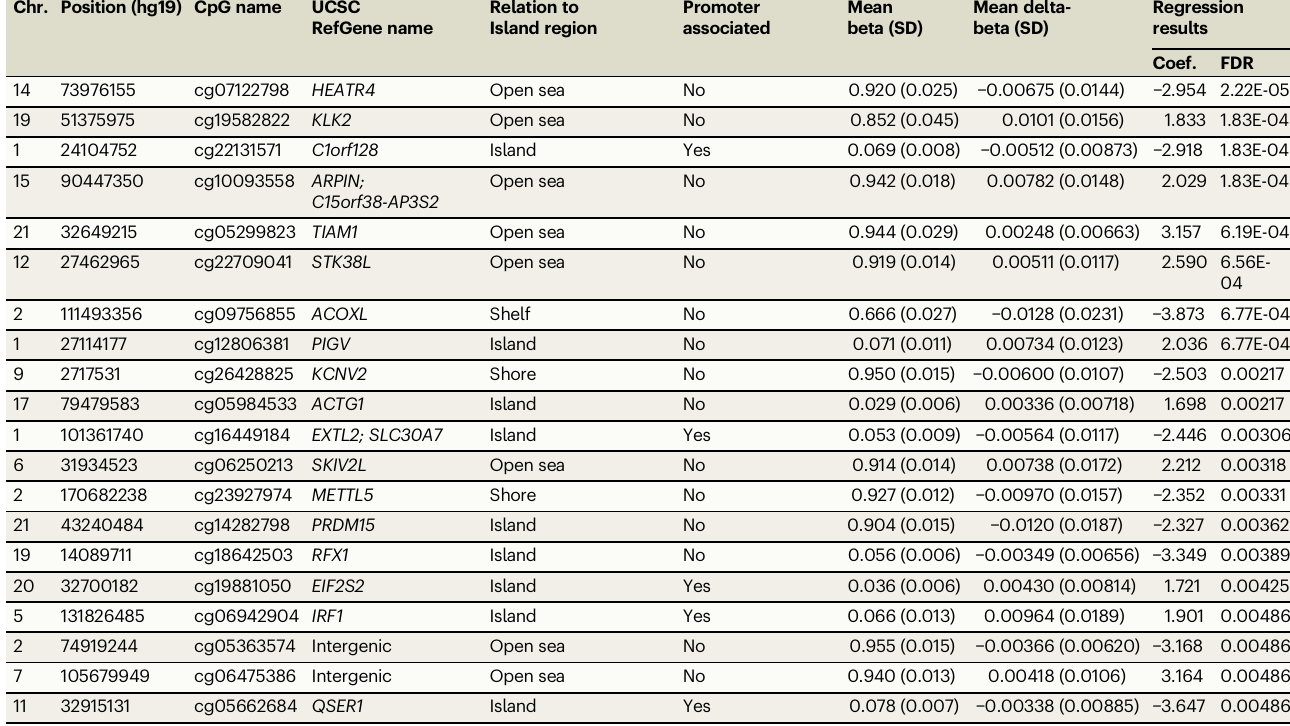
Table 2 | Top differentially methylated probes from conditional regression